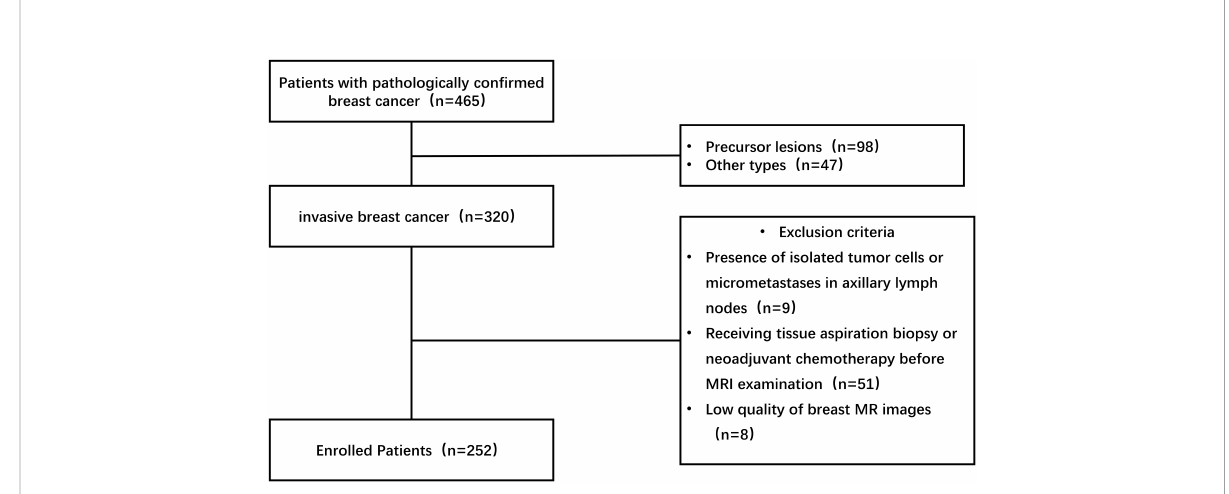
FIGURE 1 Process of enrolling patients with invasive breast